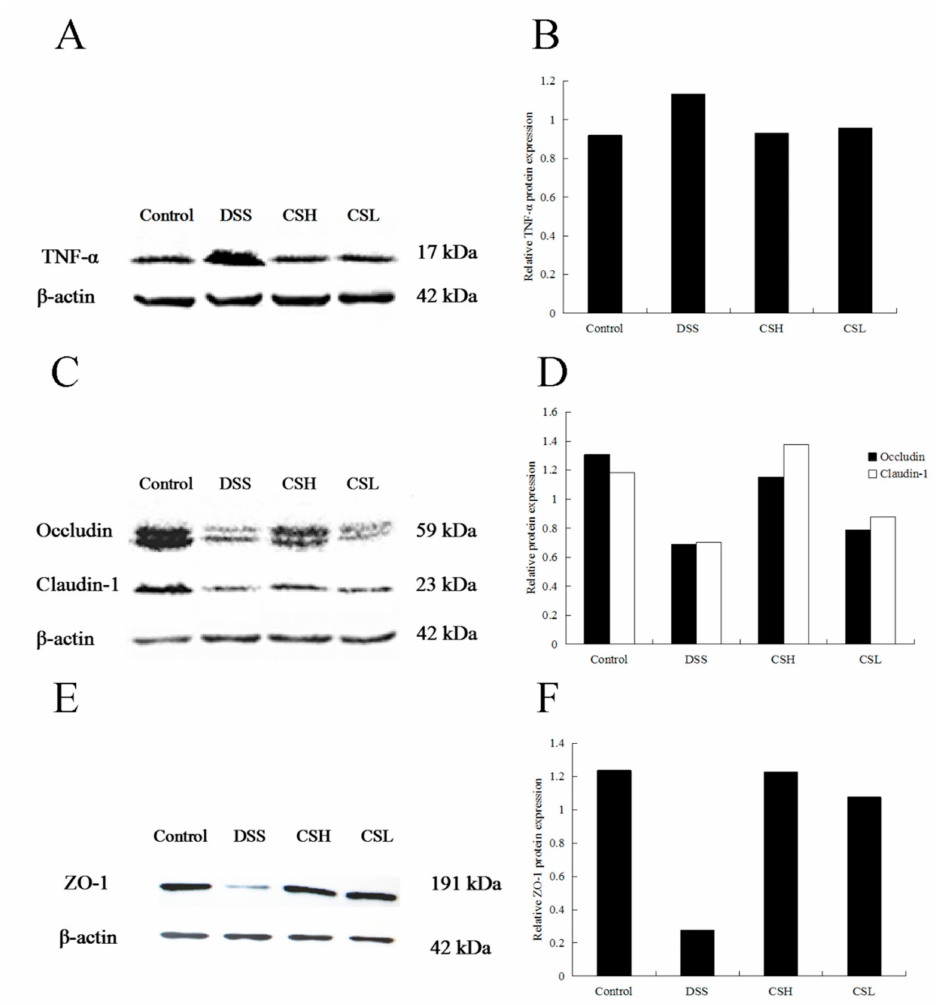
Figure 3. E ff ects of CS on protein expression of TNF- α , claudin-1, occludin, and ZO-1. Control: normal mice; DSS: mice treated with 3% DSS alone; CSH: mice treated with DSS plus chitosan (250 mg / kg); CSL: mice treated with DSS plus chitosan (150 mg / kg). Values are expressed as mean ± SD ( n =